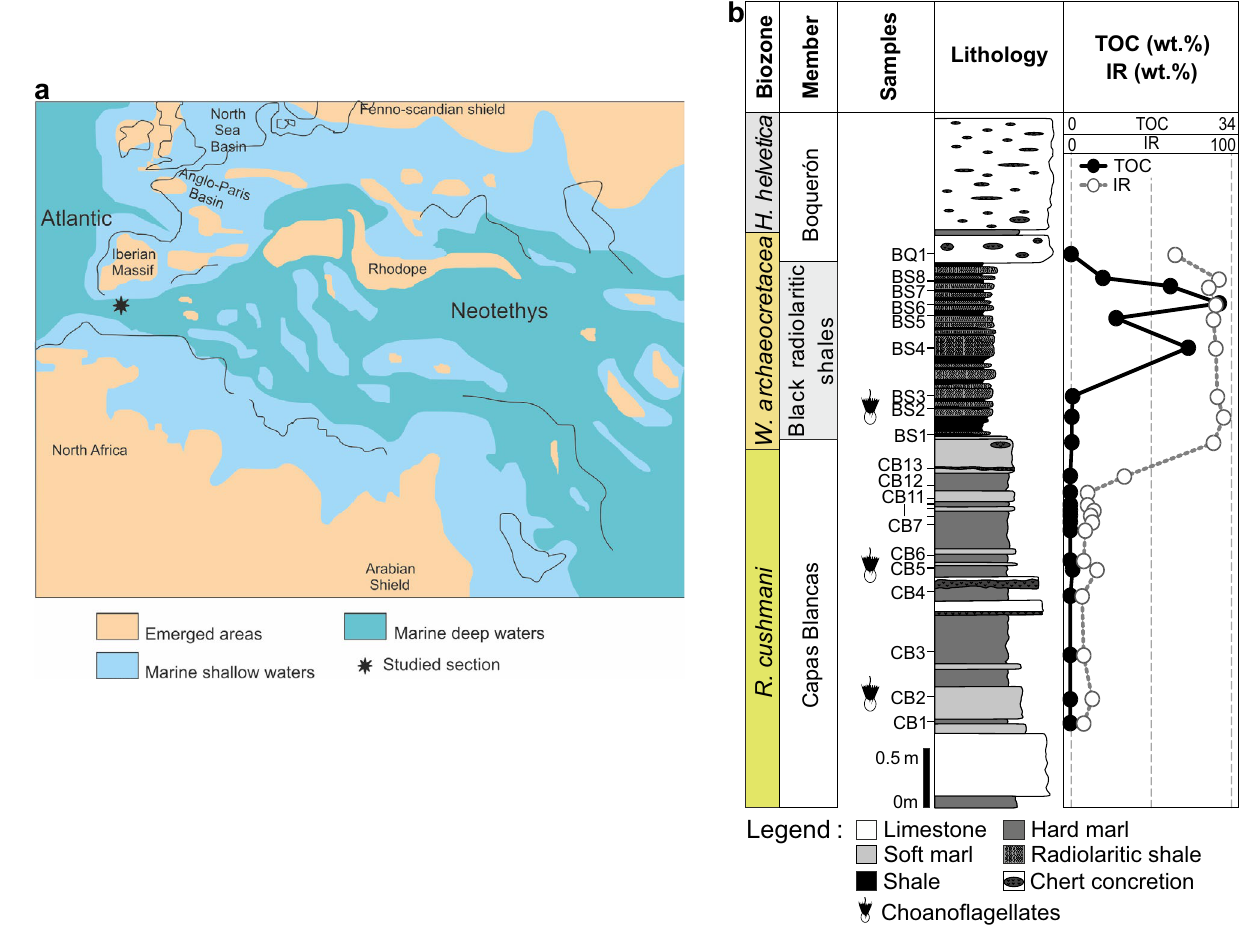
Figure 1. Baños de la Hedionda Section. ( a ) Paleogeographic map of the Cenomanian–Turonian with location of the studied section (modified from Reolid et al. 57 . ( b ) Stratigraphic logs of the Baños de la Hedionda Section. Highlight of sample location, and identification of samples with choanoflagellates in the R. cushmani and W. archaeocretacea biozones (CB2, CB5 and BS1). Total organic carbon (TOC) and insoluble residue (IR) values are plotted for each sample, with highest values being observed in the Black radiolaritic shales Member (average 15.78 wt.% and 89 wt.%,